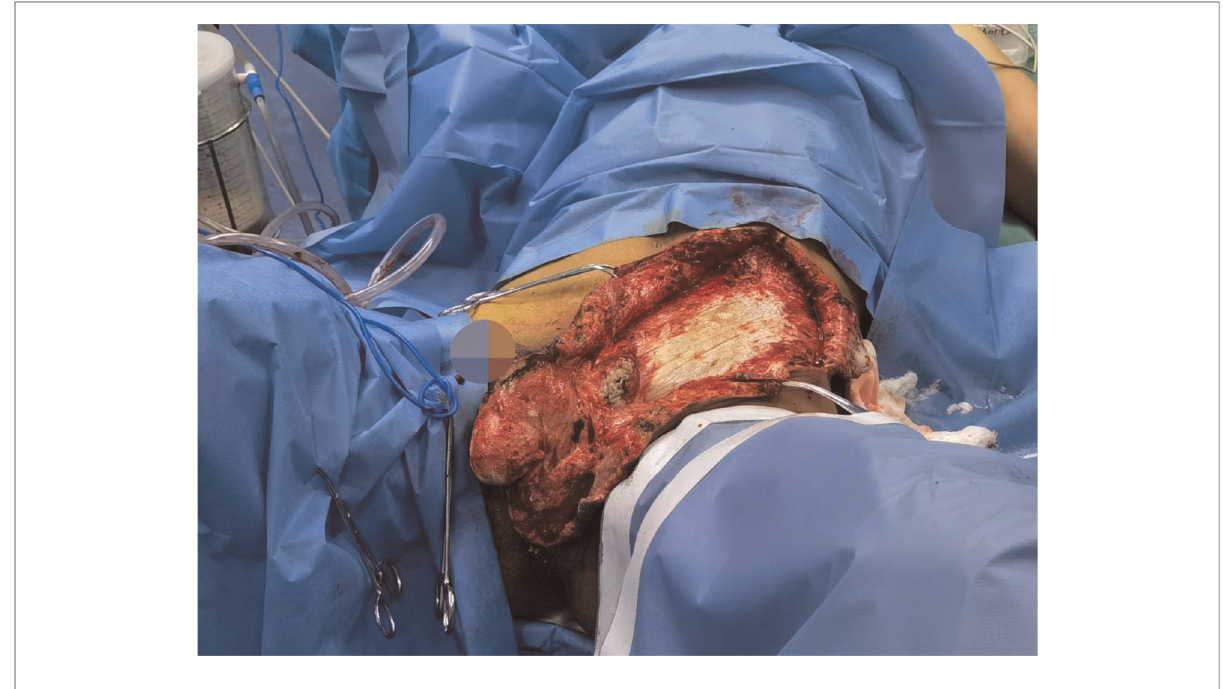
FIGURE 7 Patient 2, during secondary debridement.